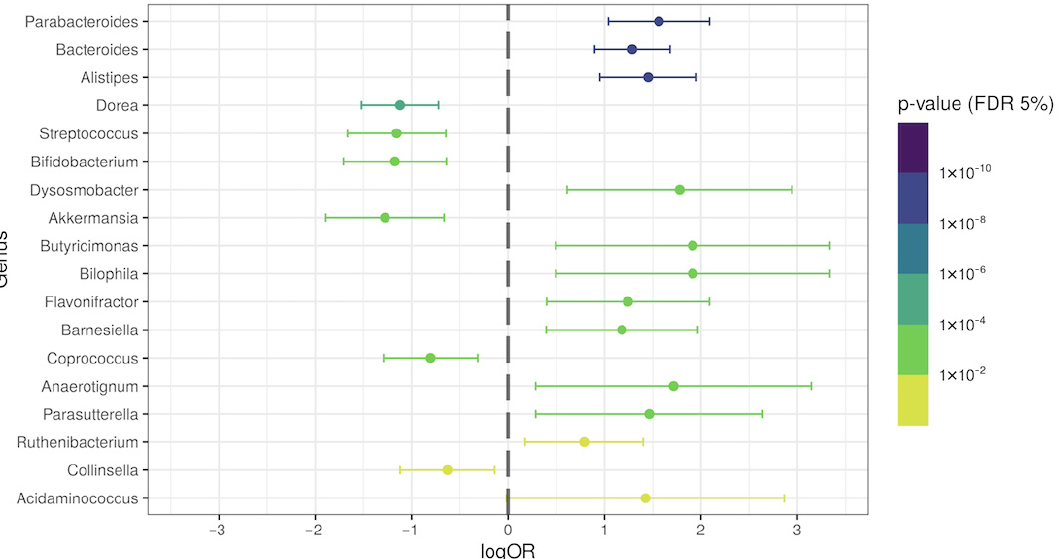
Figure 3. Differential genera relative abundance analysis of the intestinal microbiota in general post-COVID-19 patients ( n = 149), compared with control subjects ( n = 71).